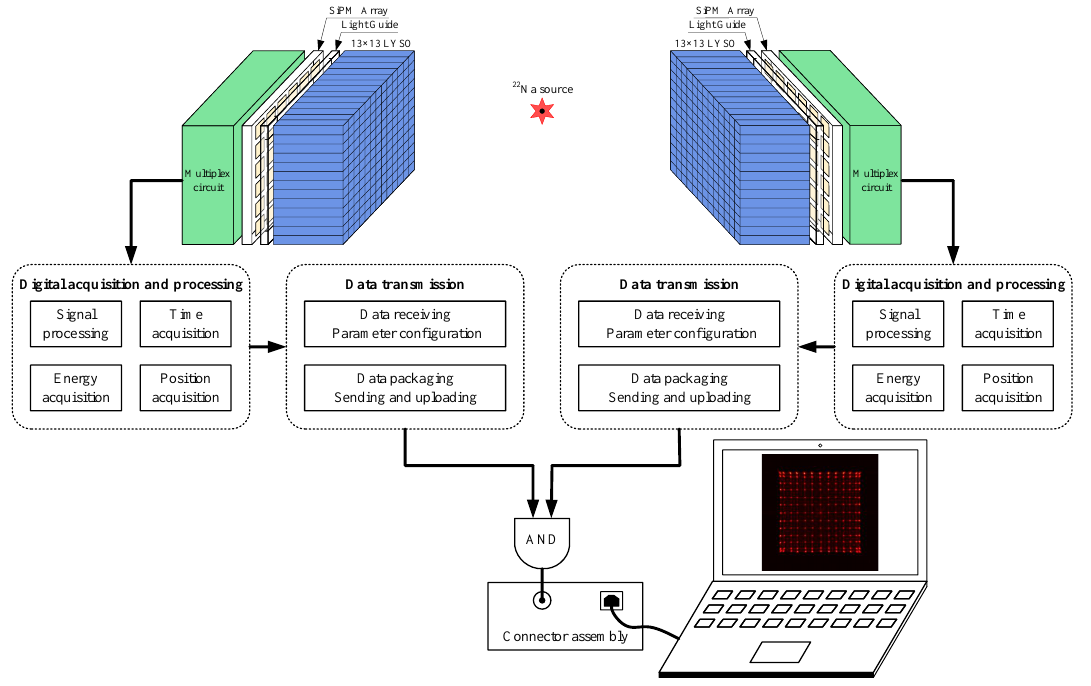
Figure 10. Figure illustrating the experimental setup in the coincidence